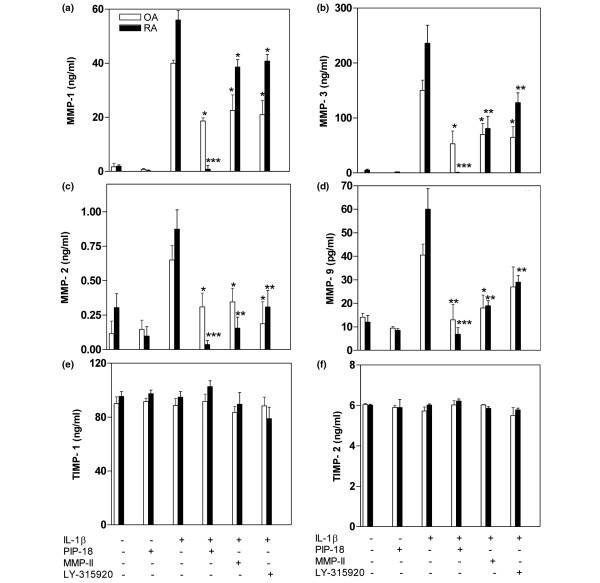
Suppressive effects of PIP-18 versus sPLA2 and MMP inhibitors on MMP secretion. Osteoarthritis (OA) and rheumatoid arthritis (RA) synovial fibroblast (SF) cells were incubated for one hour with 5 μM phospholipase inhibitor from python (PIP)-18, matrix metalloproteinase (MMP)-II inhibitor or secretory phospholipase A2(sPLA2) inhibitor LY-315920, stimulated overnight with rhIL-1β (10 ng/ml), and supernatants assayed for MMP secretions by ELISA: (a) MMP-1, (b) MMP-3, (c) MMP-2, (d) MMP-9, (e) tissue inhibitor of metalloproteinase (TIMP)-1, (f) TIMP-2. Results are the mean ± standard error of the mean of the combined data of triplicate determination of triplicate experiments done on a pool of RA SF cultures from five RA patients. Bonferroni's post hoc test was done only if the analysis of variance single-factor test was found significant. *P < 0.05, **P < 0.01, ***P < 0.001 for pair-wise comparisons (IL without inhibitor versus IL with each of the inhibitor used in the study.